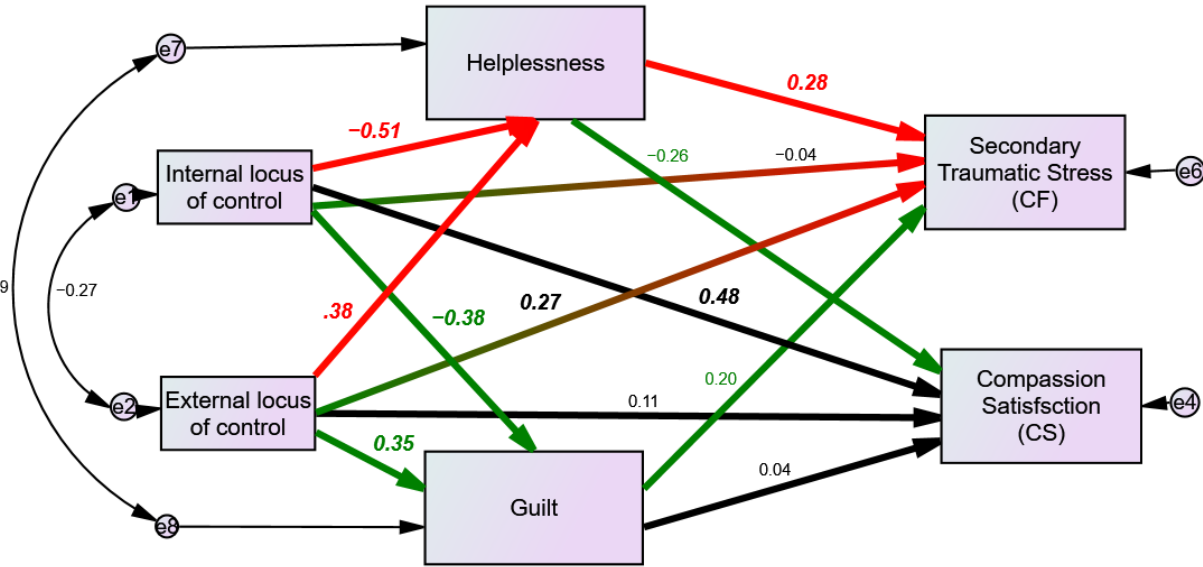
Figure 1. The mediation hypotheses (red and green paths) via SEM analysis. Bold numbers repre- senting significant associations.